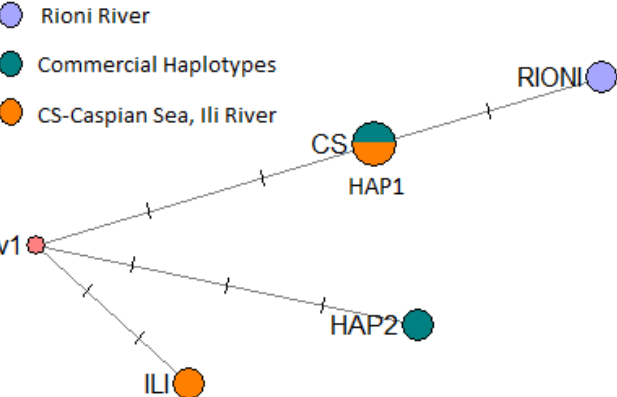
Figure 2. Network analysis of ship sturgeon samples from the Rioni River and ship sturgeon control region DNA sequences downloaded from NCBI (Caspian Sea-KU321568; Ili River-KU321569, (Balkhash basin); HAP0-KU321569; HAP02-KU321568). Analysis was carried out with 782 bp fragments of mitochondrial control region sequences.